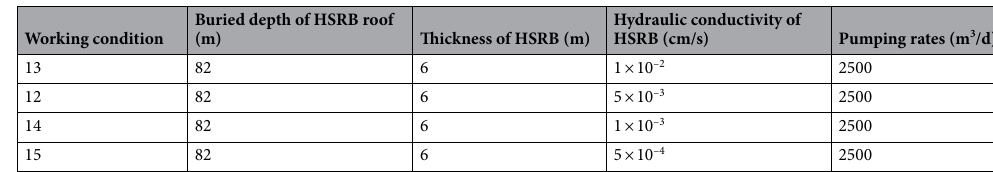
Table 7. Working conditions of HSRB with different hydraulic conductivities.